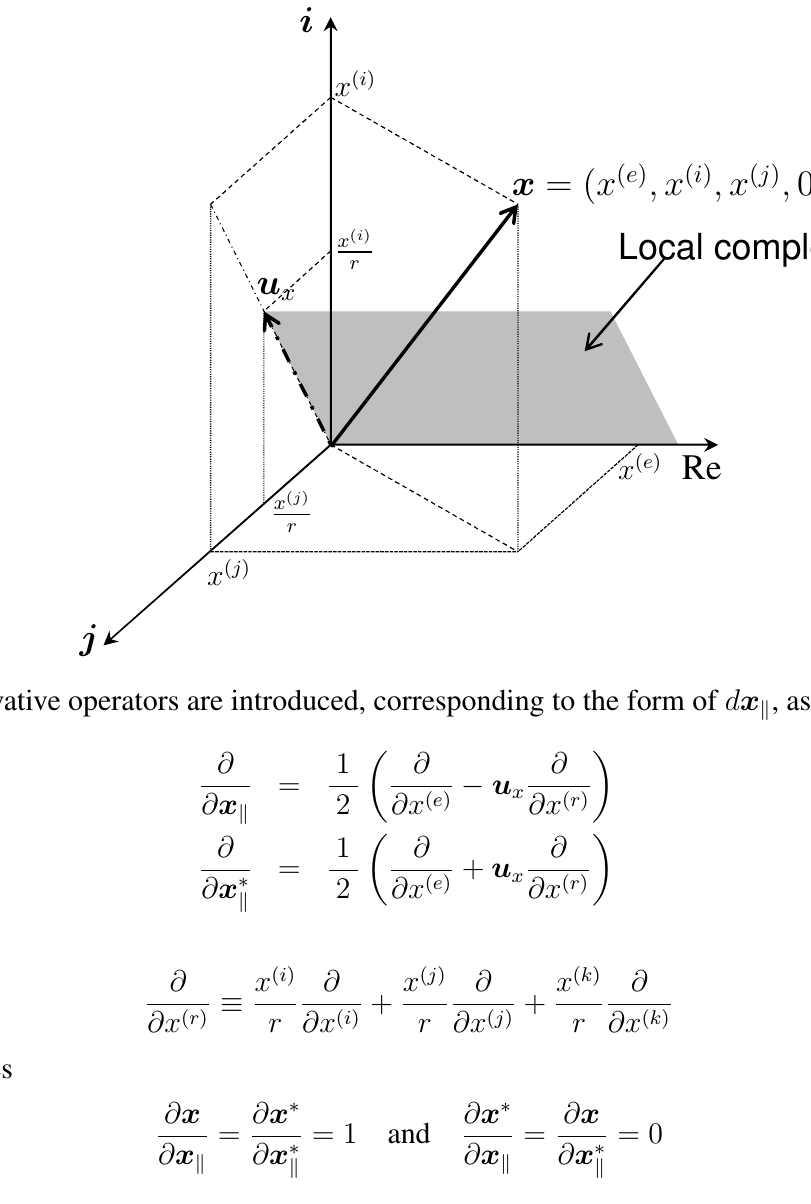
Figure 1. A schematic illustration of local complex plane in a quaternionic space, where the component k is omitted for